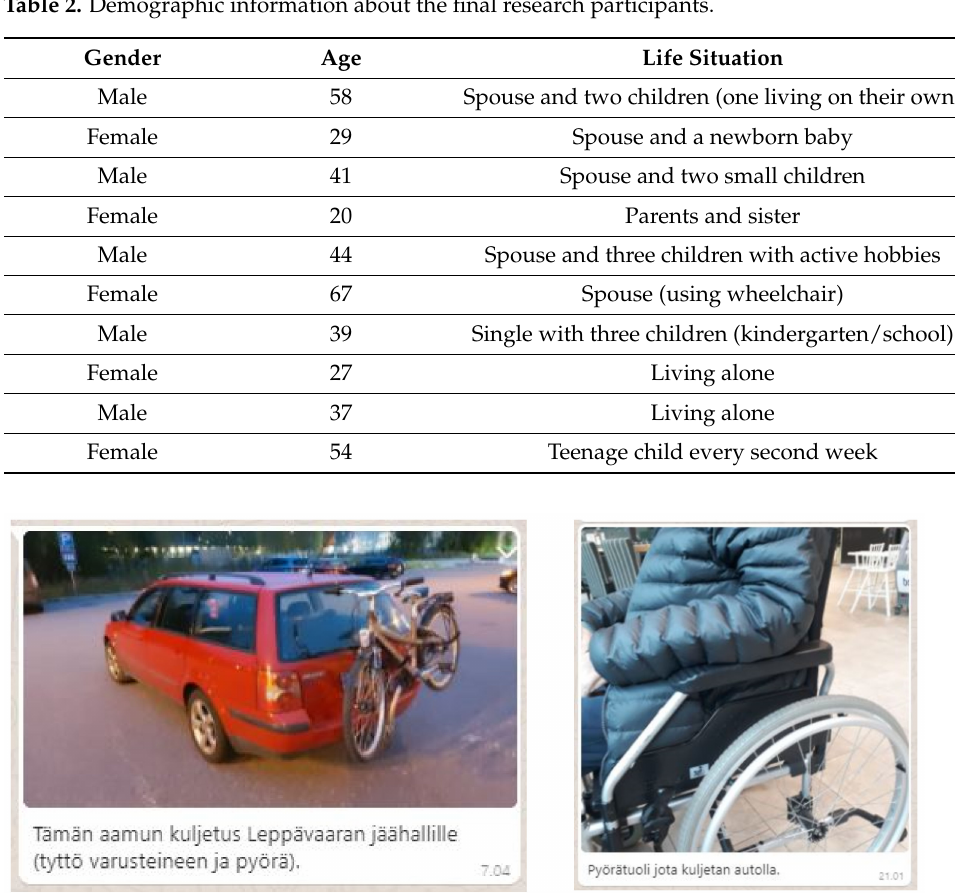
Figure 1. Two screenshots from the WhatsApp probing contents sent by the participants—driving daughter and her bike to the ice rink ( left ) and travelling with a wheelchair ( right